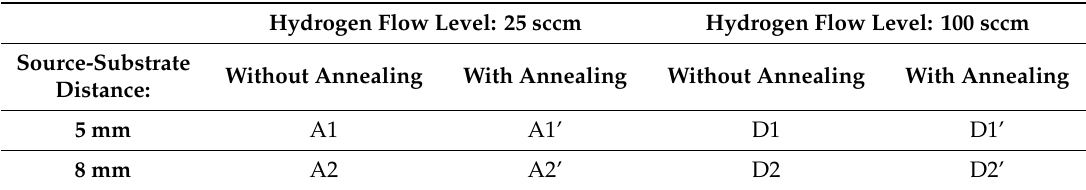
Table 1. Description of the labeling of the eight SiO x films